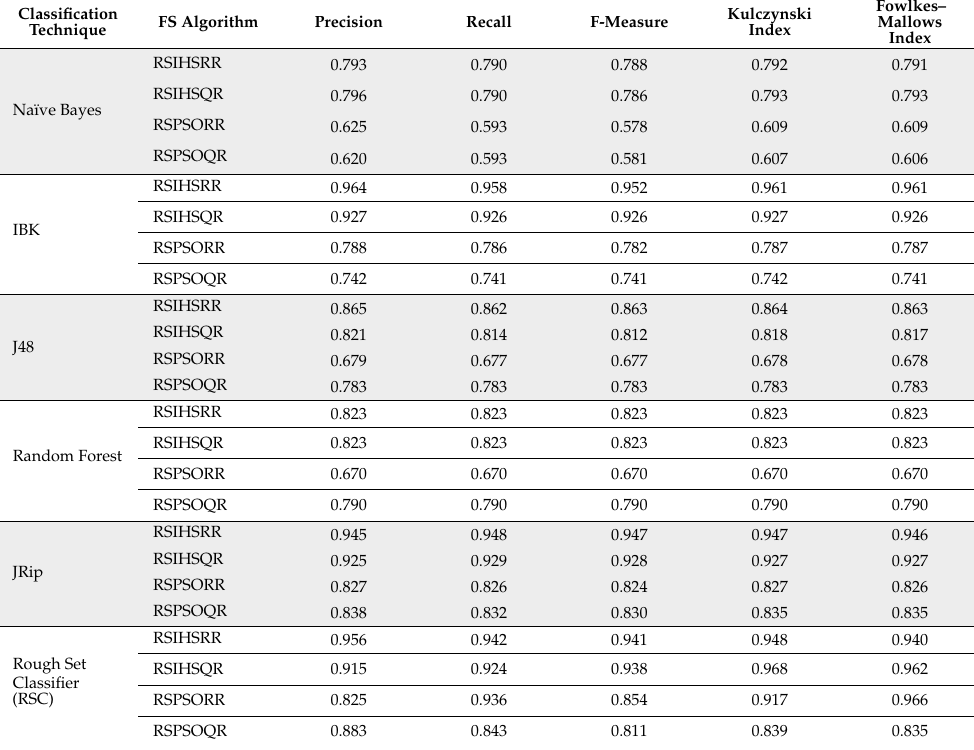
Table 3. Results of the proposed framework and other FS and classification